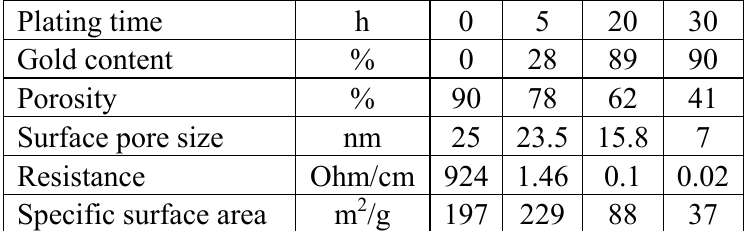
Table 1. Properties of the gold electroless plated